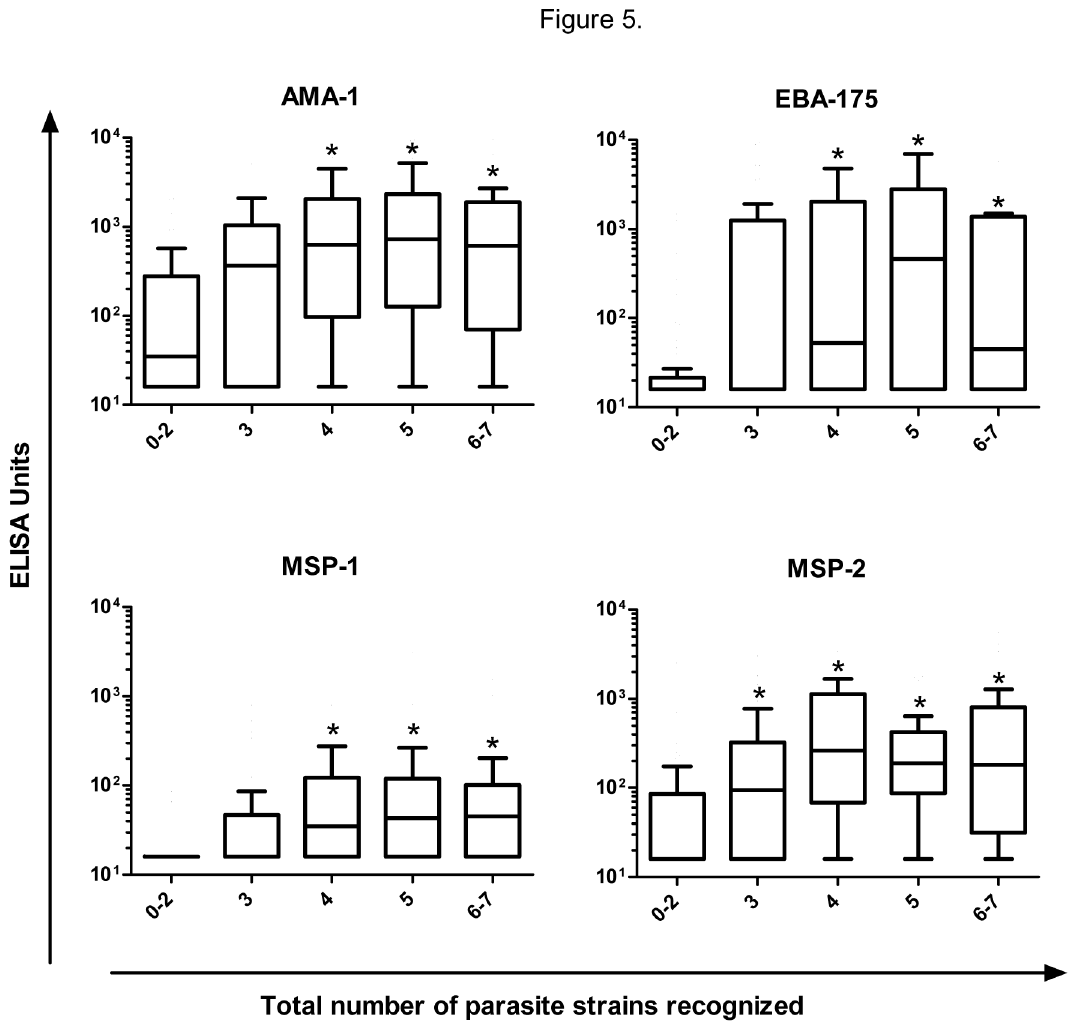
Figure 5. The breadth of IgG responses to parasite strains correlates with increased IgG titers to merozoite antigens. IgG titers to 4 merozoite antigens (AMA-1, EBA-175, MSP-1, MSP-2) were measured in plasma obtained before the transmission season, and stratified by the total number of parasite strains recognized by IgG. Tukey whisker plots are shown. IgG titers were compared using Kruskal-Wallis test followed by Dunn’s multiple comparison test. *p<0.05. The numbers of children recognizing 0-2, 3, 4, 5 and 6-7 parasite strains were 45, 34, 32, 36 and 30.